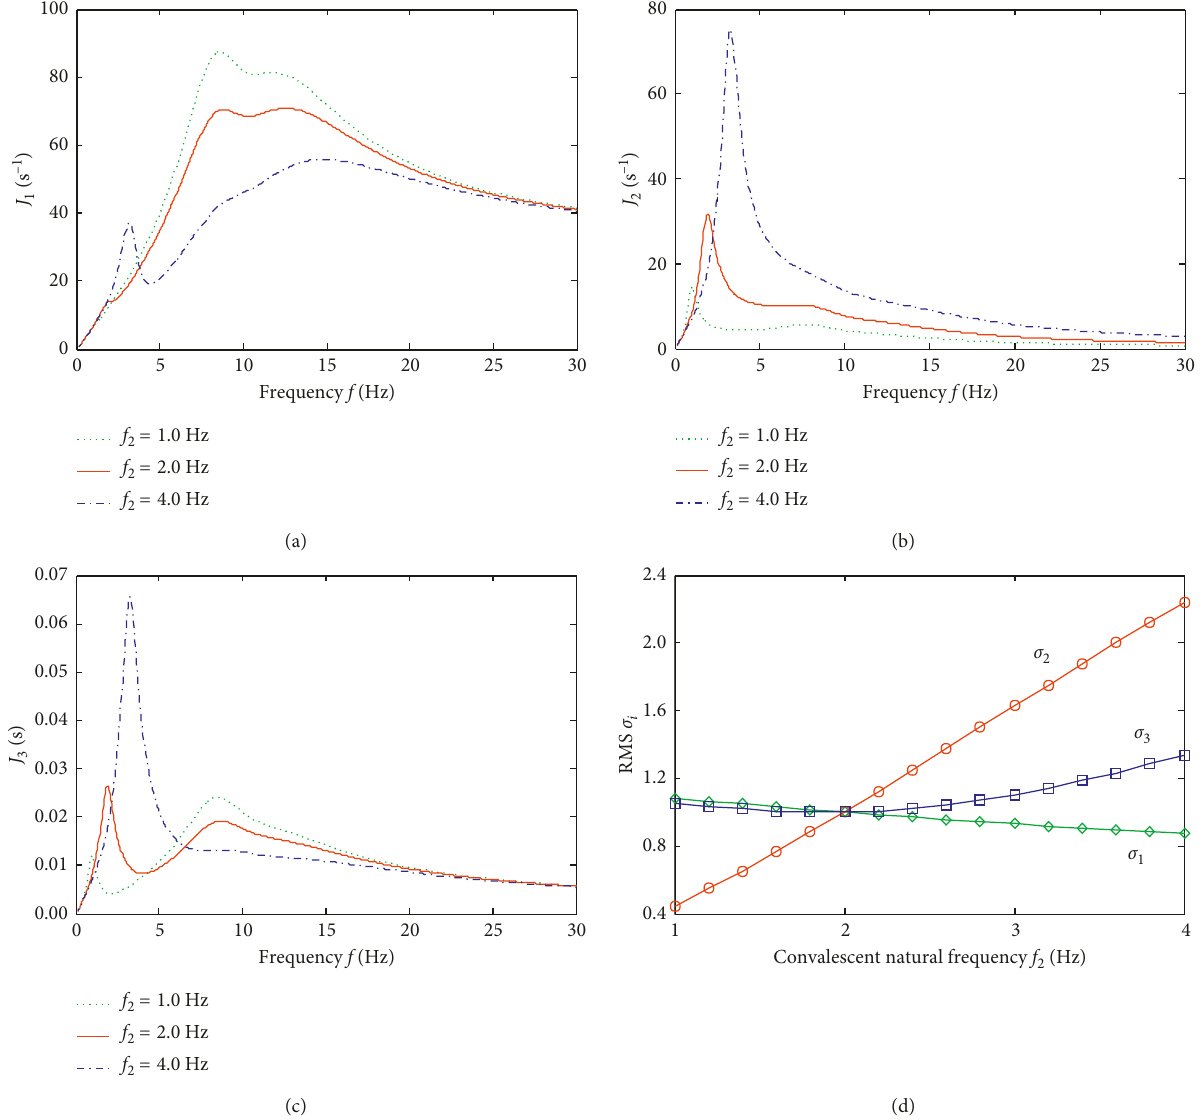
Figure 9: Influences of f on € z , € z , and f : (a) the amplitude frequency characteristics J 2 1 2 d at different values of f ; (c) the amplitude frequency characteristics J frequency characteristics J 2 2 σ , and σ versus f 2 3 2